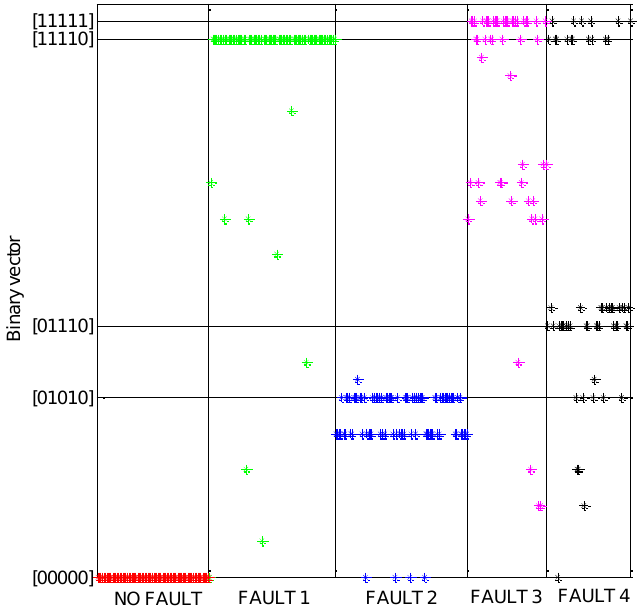
Figure 6. Binary vectors, from [0 0 0 0 0] to [1 1 1 1 1], produced by the model-based FDI system (see Figure 1) for the SOFC plant operating under healthy and faulty conditions. For a given fault, each asterisk indicates the binary vector produced by a given combination between the operating condition and fault size. The constant-voltage control for the SOFC plant is considered, the maximum percentage error is 4%, and the relative threshold Ω is 4.5%.